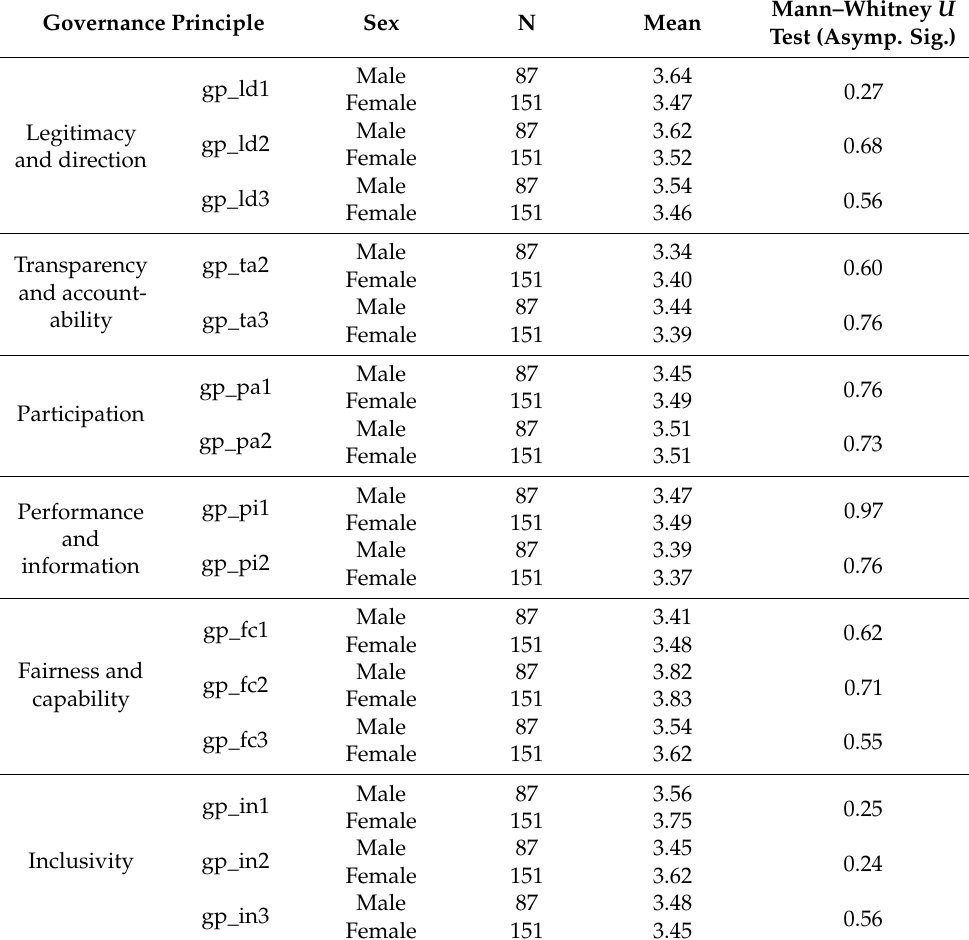
Table 10. Test of difference: